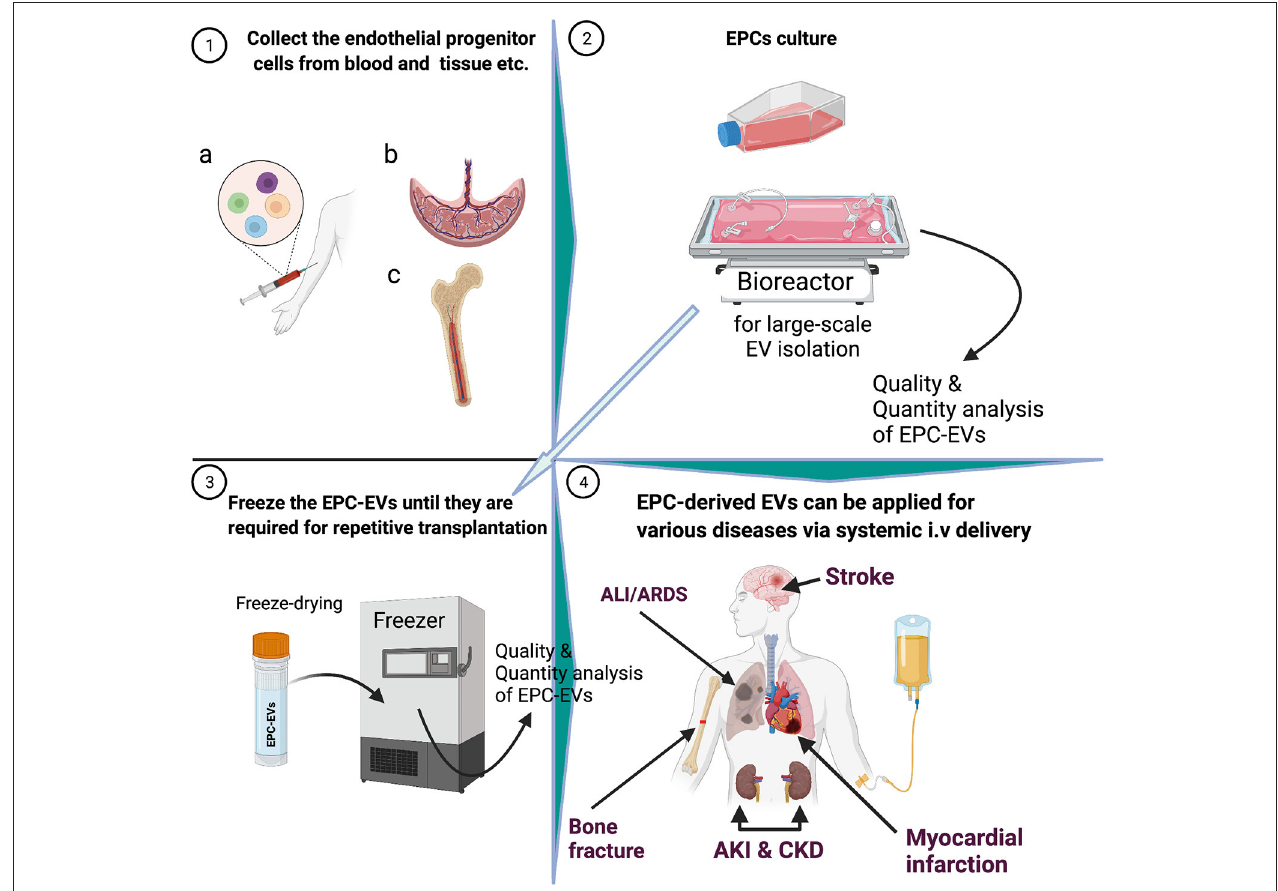
FIGURE 1 | Graphical